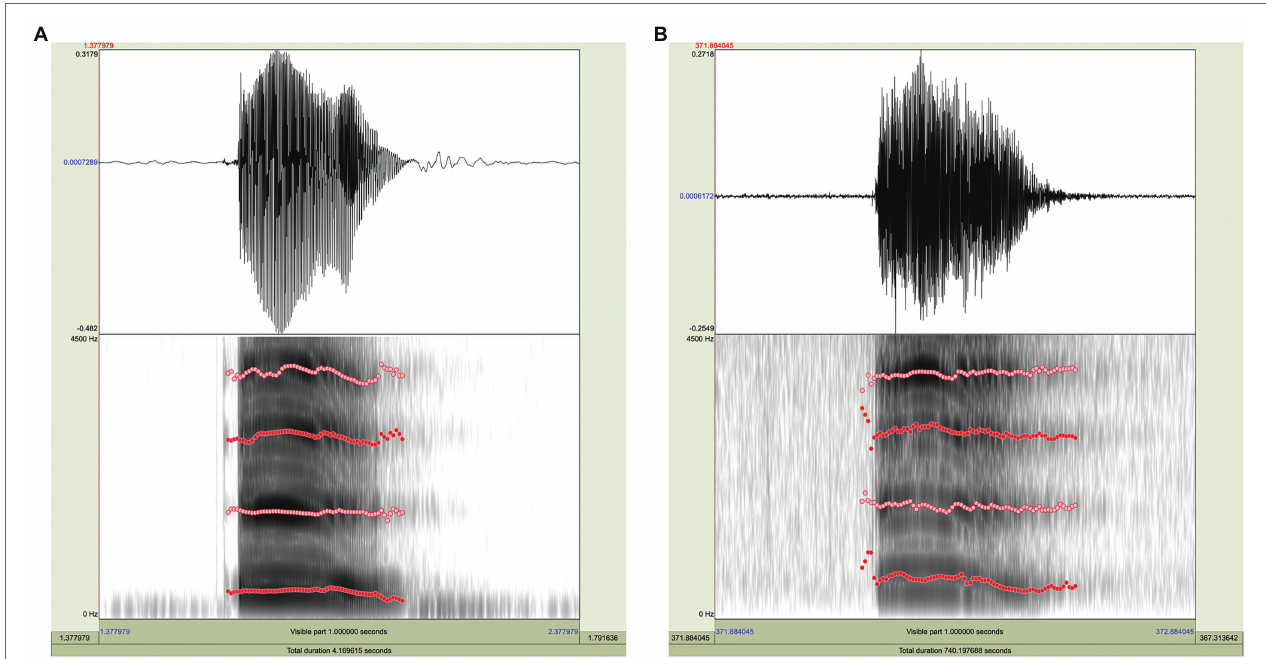
FIGURE 5 | Quality comparison between in-laboratory and in-home audio recording systems in the Imitation study (Cai & Kuhl, in prep). Panel (A) shows the spectrogram (with formant tracking) of vowel /ø/, recorded with the laboratory audio recording system, sampled at 44.1 kHz. Panel (B) shows the spectrogram (with formant tracking) of an in-home LENA recording of the same vowel, sampled at 16